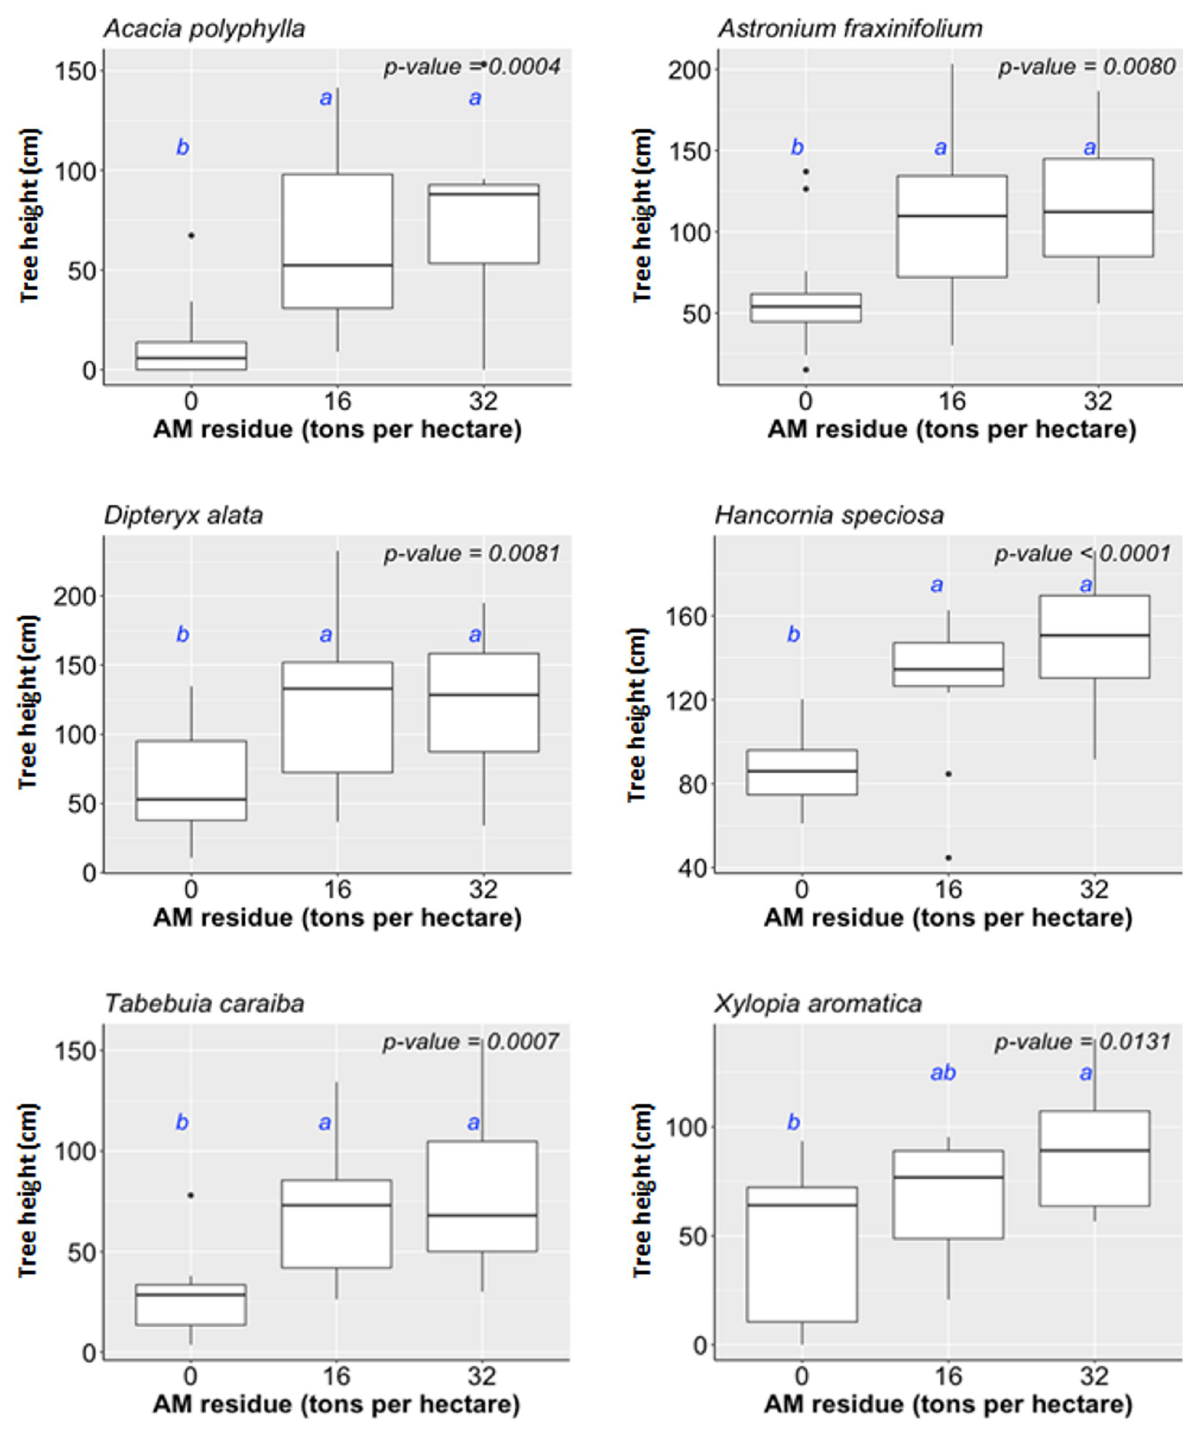
Fig 5. Influences of AM residues on tree height.